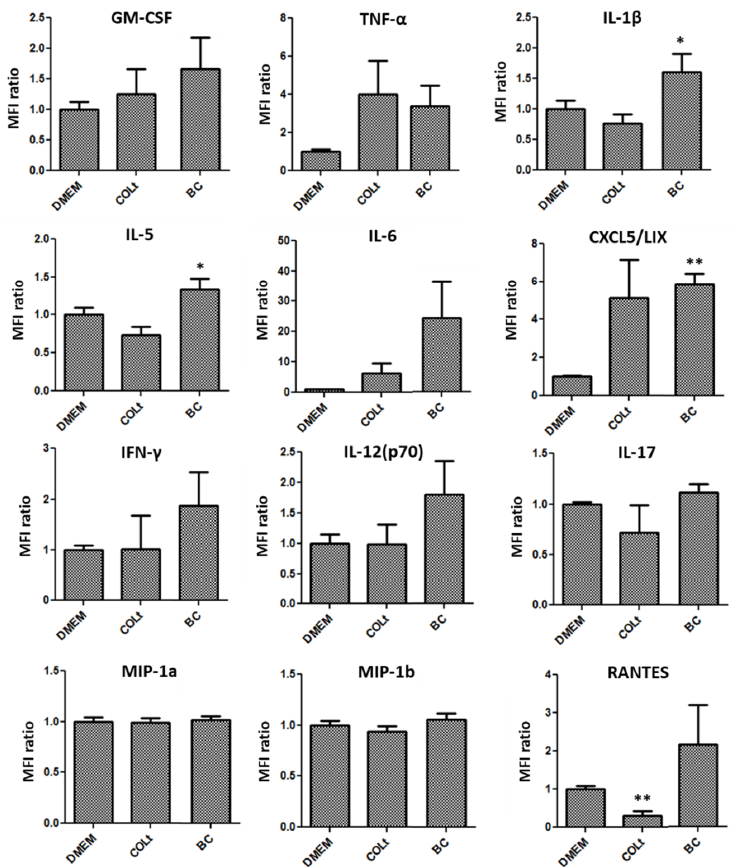
Figure 8. Expression of M1 macrophage-related cytokines secreted by macrophages cultured on bacterial cellulose (BC) scaffold, collagen total type material (COLt), or in DMEM for 24 h (GM-CSF = granulocyte-macrophage colony-stimulating factor; TNF-α = tumor necrosis factor-alpha; IL-1β = interleukin-1 beta; IL-5 = interleukin-5; IL-6 = interleukin-6; CXCL5/LIX = chemokine (C-X-C motif) ligand 5/lipopolysaccharide-induced chemokine; IFN- γ = interferon-gamma; IL- 12(p70) = interleukin-12(p70); IL-17 = interleukin-17; MIP1a = macrophage inflammatory protein-1 alpha; MIP1b = macrophage inflammatory protein-1 beta; RANTES = regulated on activation, normal t expressed and secreted; * p < 0.05; ** p <